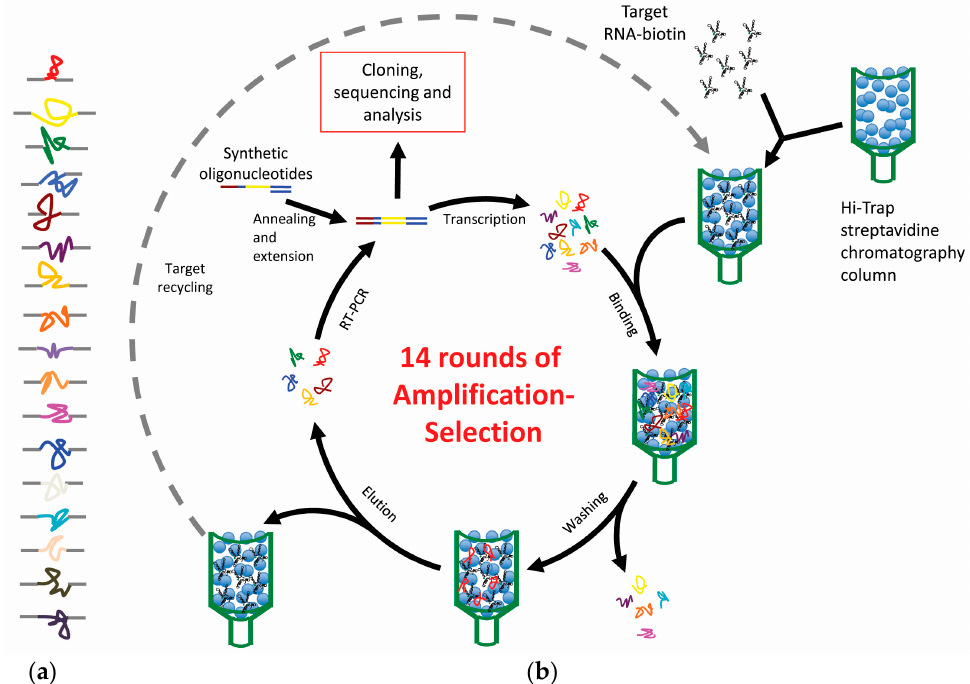
Figure 3. Schematic representation of the SELEX procedure we applied for the isolation of aptamers against the HIV and HCV genomic RNA fragments. ( a ) Representation of the starting population of RNA oligonucleotides that is subjected to the selection process. The colored line represents the 25–30 nt-long random sequence region. The different folding determined by the different sequence is depicted by the free hand drawing. Gray lines represent the fixed flanking sequences. ( b ) SELEX procedure. Details of the protocol are provided in [24,25].